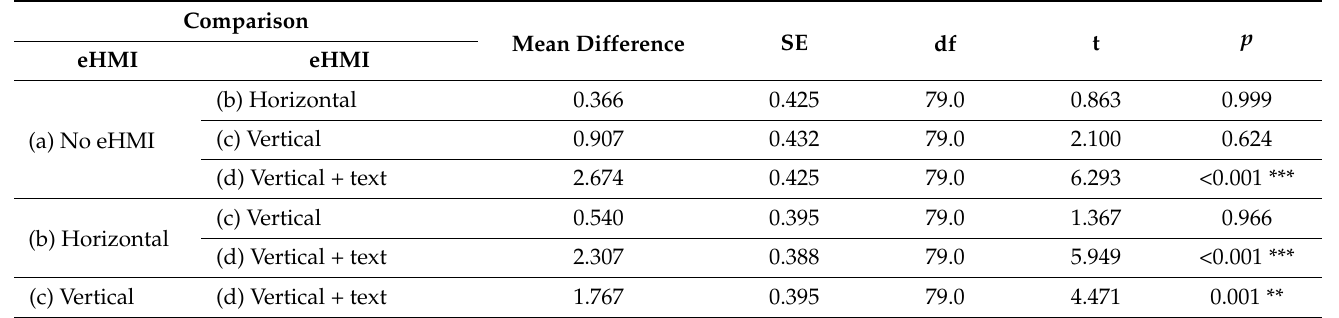
Table 7. Post-hoc comparison of the time till reach the maximum of the willingness to stop within the low frequency of driving